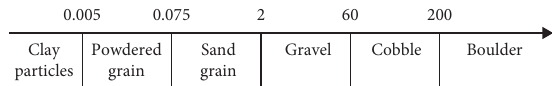
Figure 2: Particle size grouping of soil.